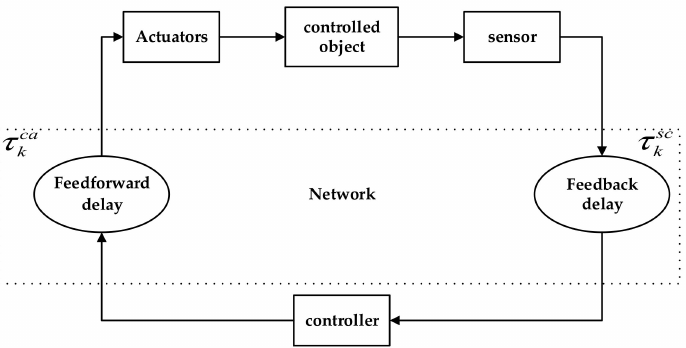
Figure 1. Structure of the network control